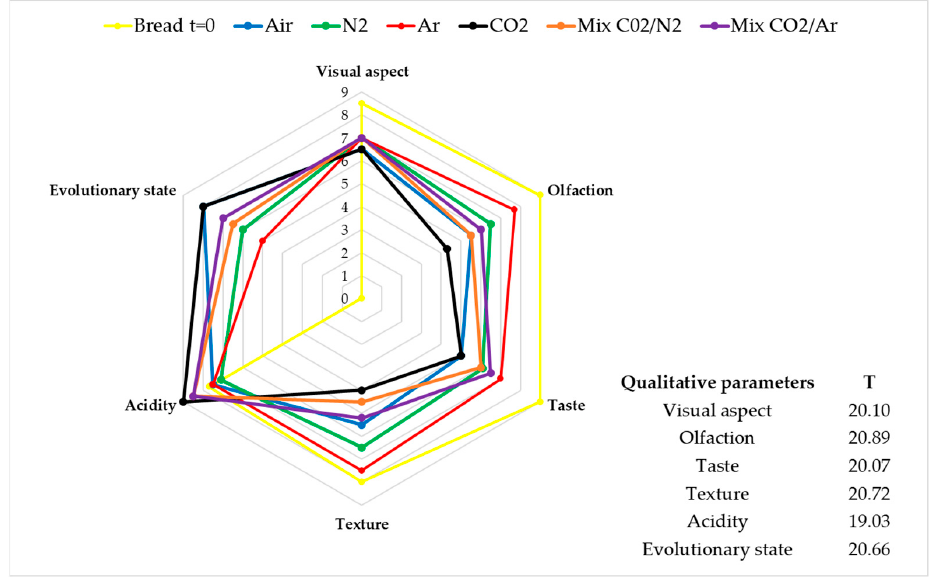
Figure 5. Median of significant qualitative parameters. Friedman’s ANOVA analysis (T > χ 2 , χ 2 =